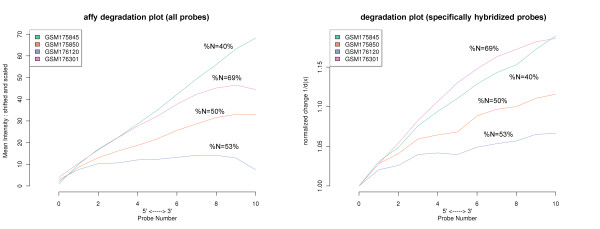
RNA degradation plot of all probes (panel a) and degradation profile of specifically hybridized probes (b) for microarrays selected from the human tissue data set. Panel a shows the plots obtained using the affy package
[16] whereas the curves in panel b are given by the inverse of the degradation function dS(k)-1 (see Eq. (10)). The slopes of most of the curves rank in the same order in both panels, except the two curves of steepest slope which reverse order in both parts of the figure owing to the different percentage of absent probes. The percentage of absent probes are %N = 40% (GSM175845), 69% (GSM176301), 50% (GSM175850) and 53% (GSM176120) as determined by the hook method
[33,34]